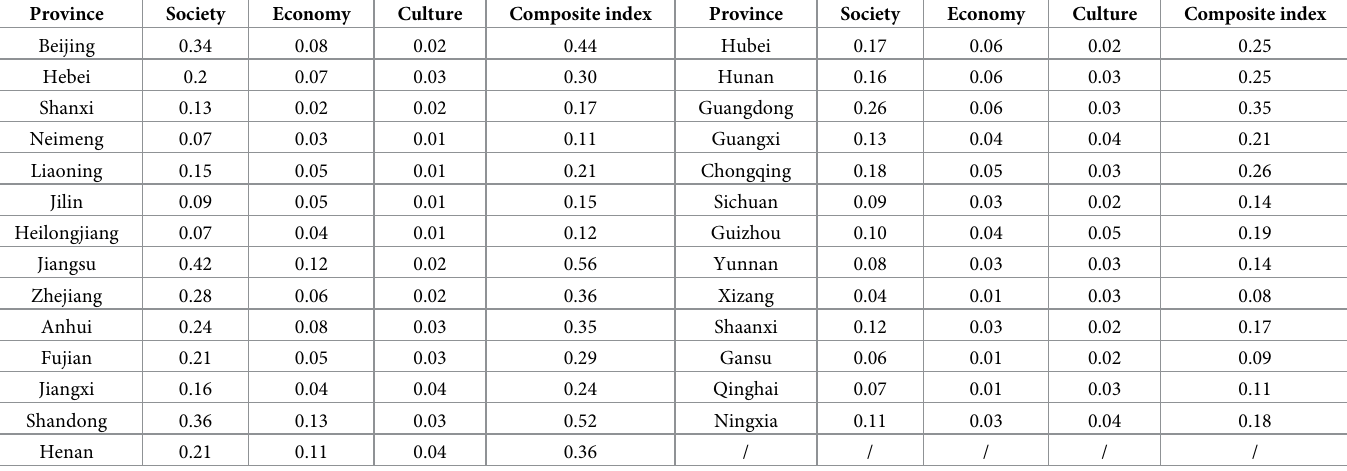
Table 6. Quantitative index of human activities in 27 provinces of China